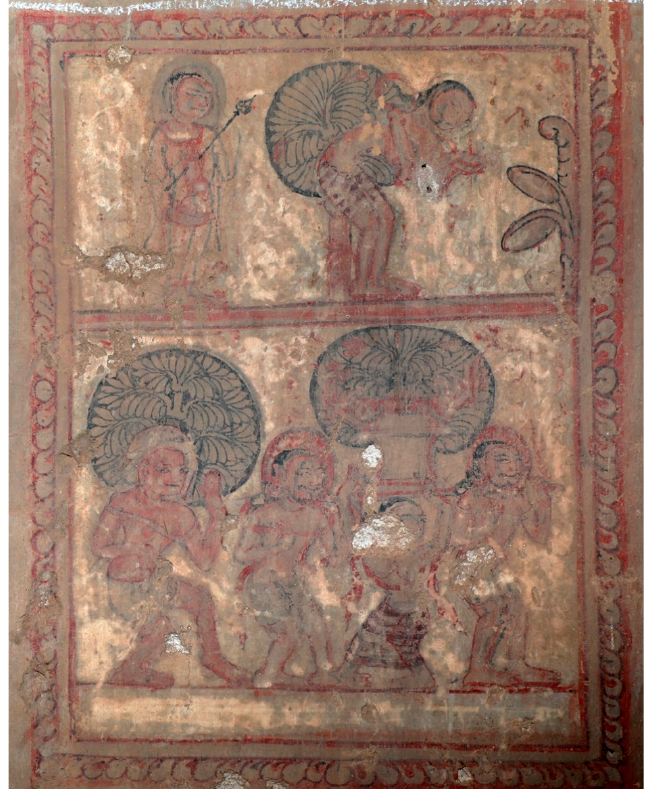
Figure 3. Pagan, Winido, 13th century, Endowment 659. The Four Omens, compressed into one frame, and featured, among numerous others, prince Siddhartha—Buddha Gotama biographical slivers.